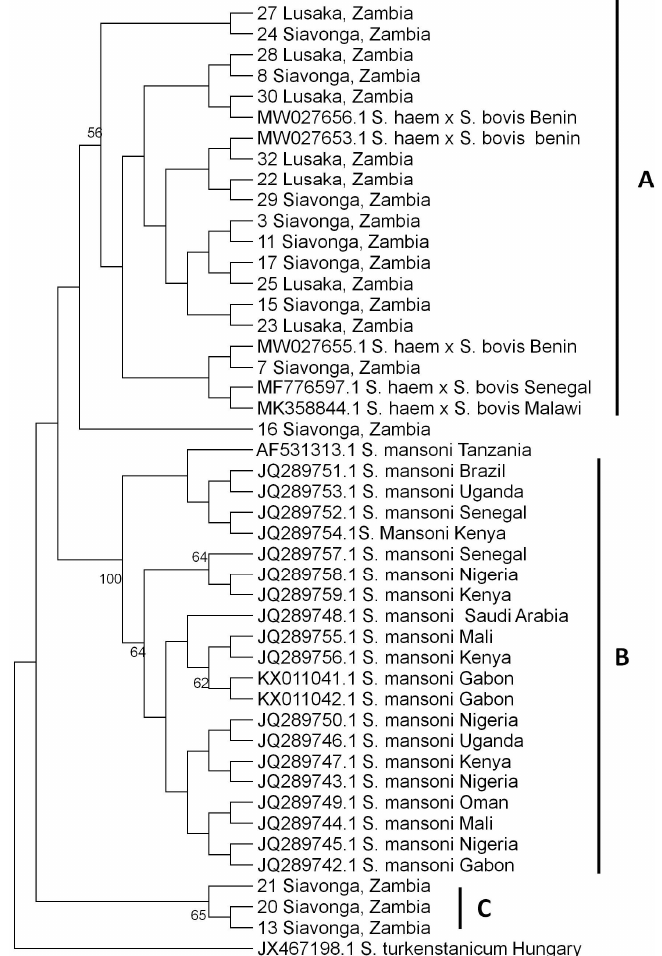
Figure 2. Schistosoma haematobium ITS maximum likelihood phylogenetic tree. The tree was gener- ated from 981 bp nucleotide sequences using MEGA ver. 6 with 1000 bootstrap replicates as a con- fidence